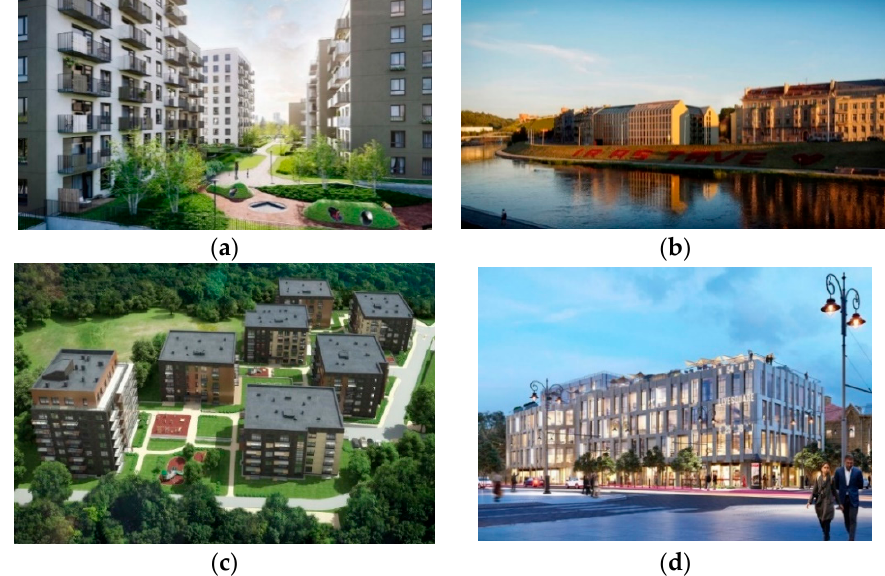
Figure 2. Four dwelling projects at the intersections under analysis: ( a ) Linkmen ų Lakes residential complex at the Kareivi ų , Kalvarij ų , and Ozo Sts. Intersection; ( b ) new Žygimant ų dwelling units in the Old Town at the Žygimant ų and T. Vrublevskio Sts. Intersection; ( c ) Veikm ė Park building at the Santariški ų and Baublio Sts. Intersection; ( d ) live Square at the Pam ė nkalnio, Jogailos, Islandijos, and Pylimo Sts. Intersection.